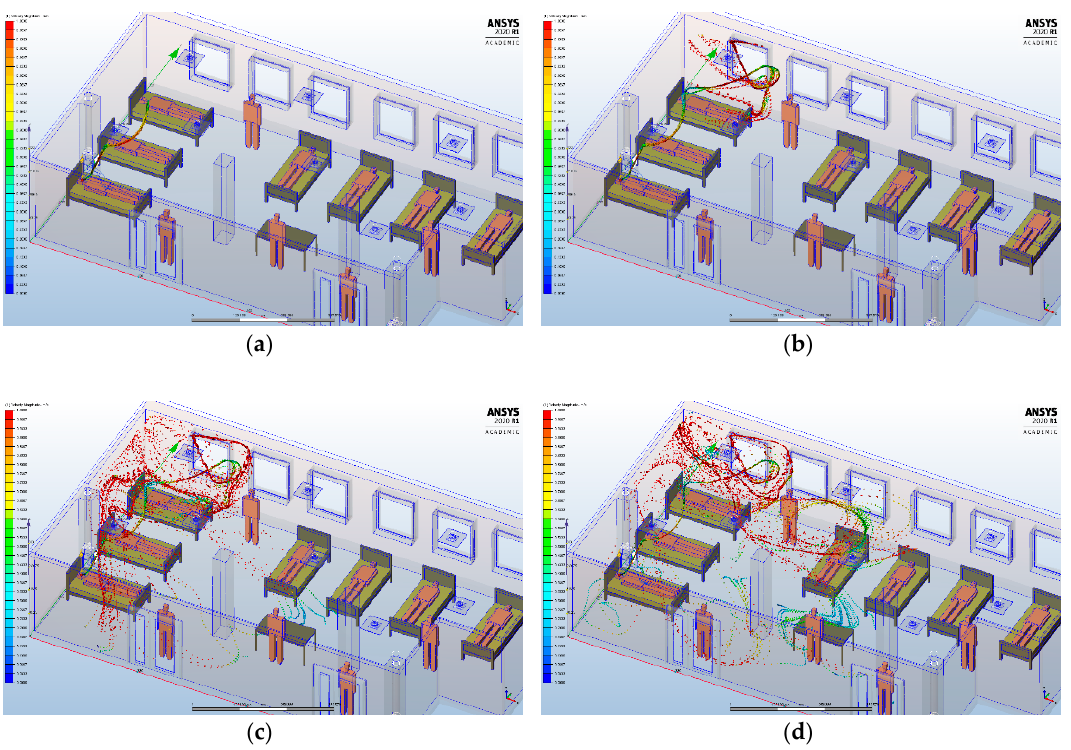
Figure 8. Transient analysis of the lighter particles dispersion carried into the air by buoyancy for HVAC systems, at di ff erent time intervals, if the infected patient is in the left part of the intensive care unit: ( a ) 2 s; ( b ) 3 s; ( c ) 4 s; ( d ) 5 s.